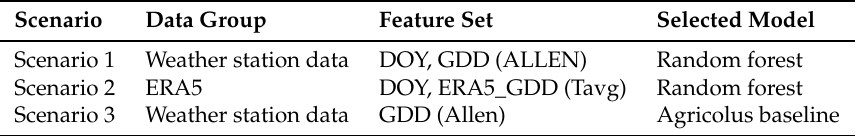
Table 3. Scenarios for comparing selected ML models to Agricolus’ baseline